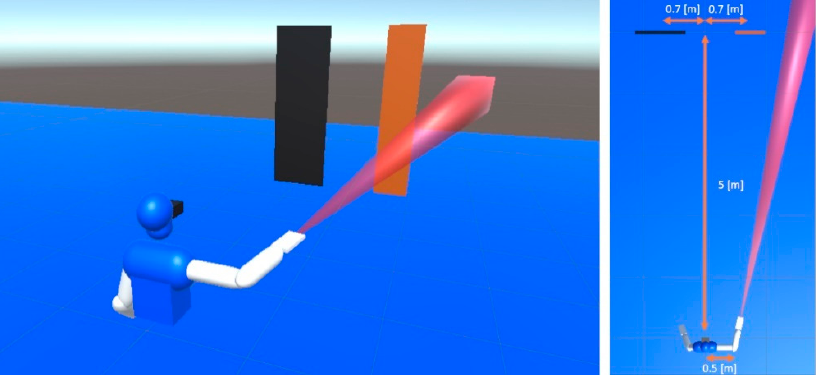
Figure 3. Test of relative width with a haptic SSD. The detection area of the SSD is in red.